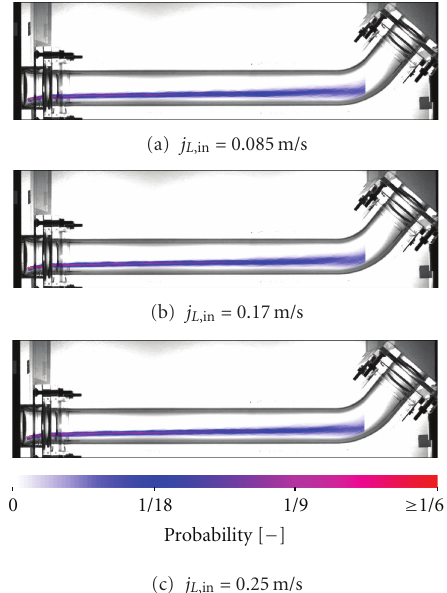
Figure 9: Evolution of the probability distribution of the water level in function of the injected water flow rate for experiments with j G =